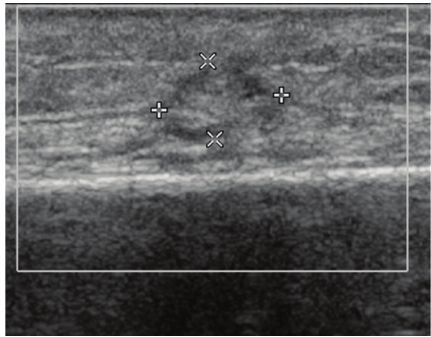
Figure 3: Ultrasound doppler 3 months after trauma. Resolution of the soft tissue edema: hyperechoic (fatty) lesion with hypoechoic halo with relatively clear boundaries. No periosteal reaction was